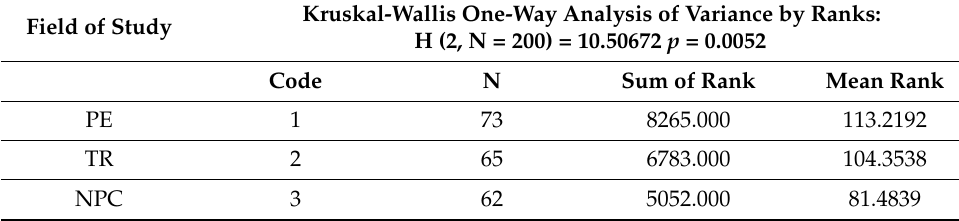
Table 10. Comparison of time spent on high physical activity during the post-lockdown period. Kruskal-Wallis One-Way Analysis of Variance by Field of Study